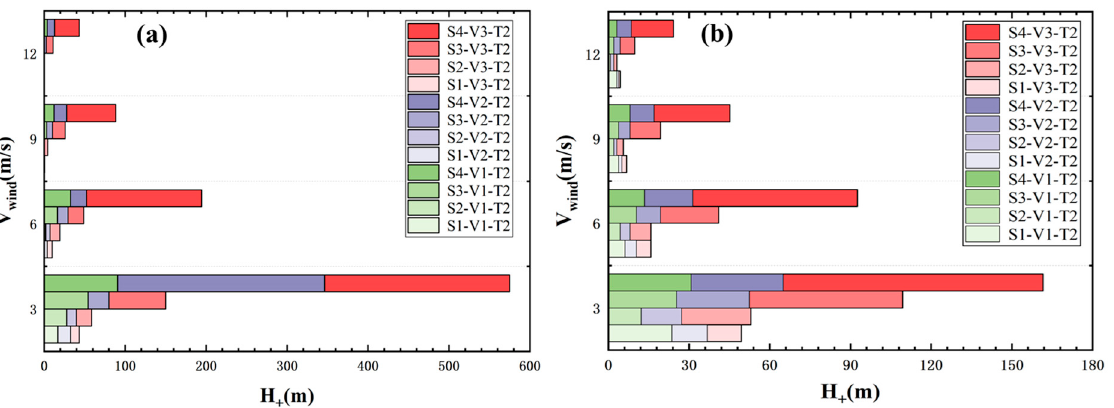
Figure 2. The rising height (H + ) of the smoke plume of the T2 group: ( a ) stationary source and ( b ) moving source.